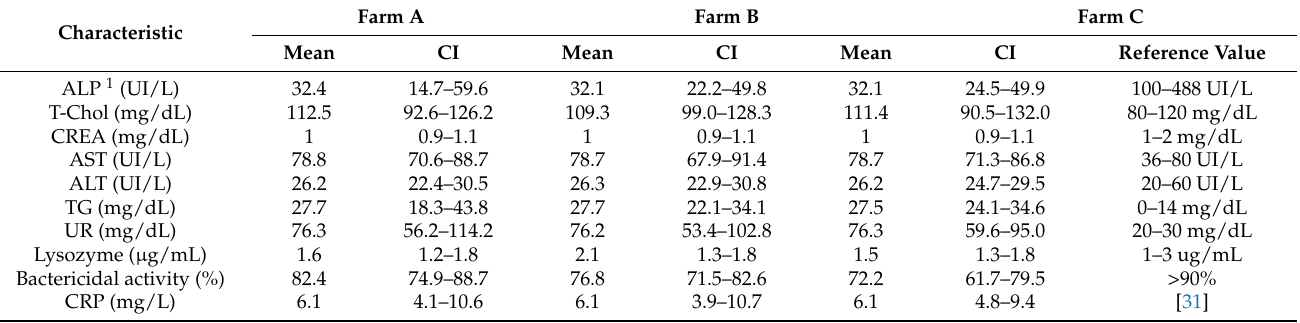
Table 4. Blood biochemical parameters in lactating cows: mean and confidence intervals (>95%).